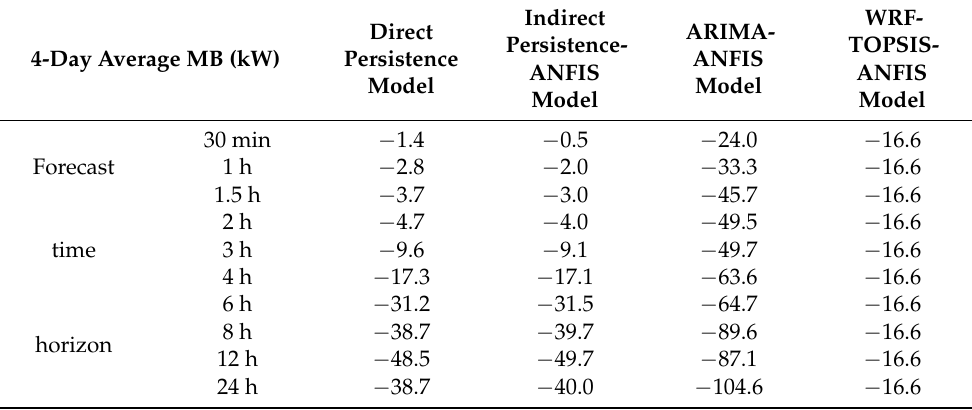
Table 13. Four-day average mean bias for the wind power forecasting using the direct persistence, indirect persistence-ANFIS, ARIMA-ANFIS, and WRF-TOPSIS-ANFIS models applied to the 4-day test dataset.